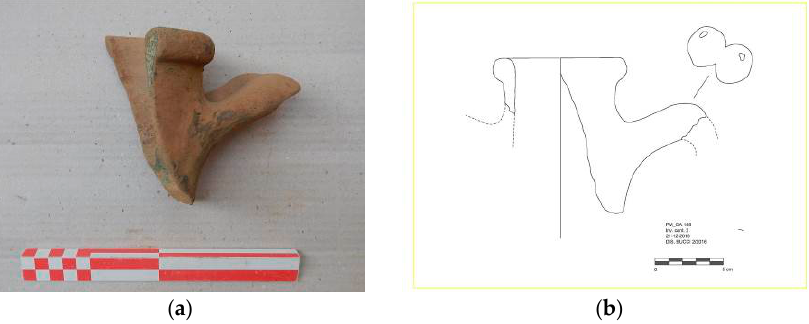
Figure 20. Fragments of Dressel 2–4 Amphora found in Lago Tramonto, Gambulaga, Portomaggiore